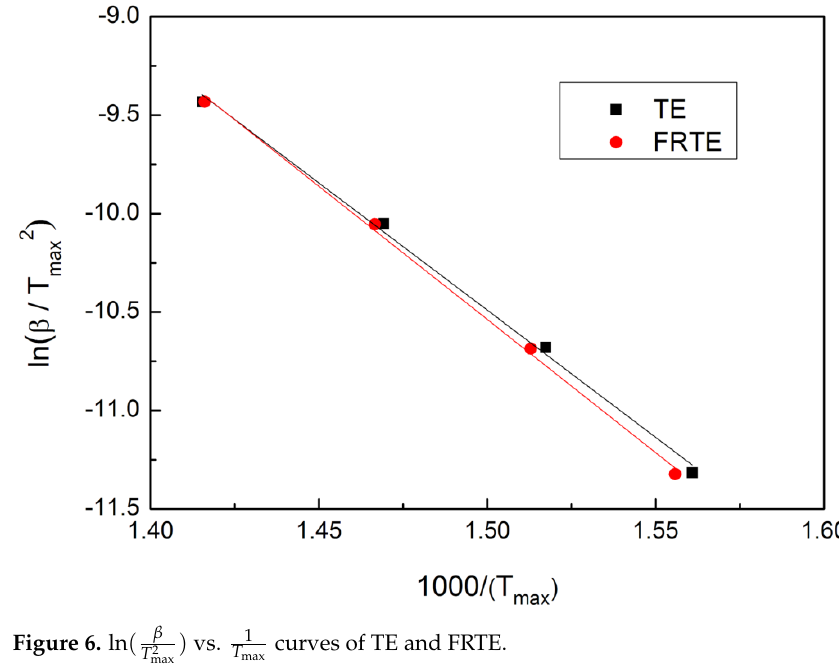
) vs. 1 Figure 6. ln ( β curves of TE and FRTE. T max T 2 max Figure 6. curves of TE and FRTE. Table 2. Kinetic data for TE and FRTE degradation by the Kissinger